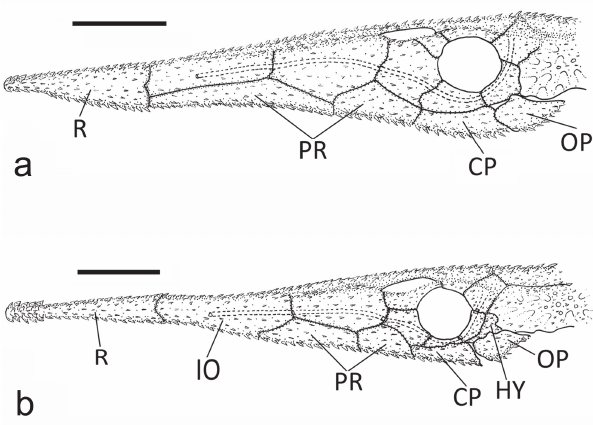
Fig. 4. Head skeleton and snout plates of: a) Acestridium discus , MZUSP 85321; and b) A. martini , MZUSP 74275. CP = canal plate; HY = hyomandibula; IO = infraorbital; OP = opercle; PR = postrostral plates; R = rostral plate. Lateral view, left side, anterior to left. Scale bar = 2 mm.